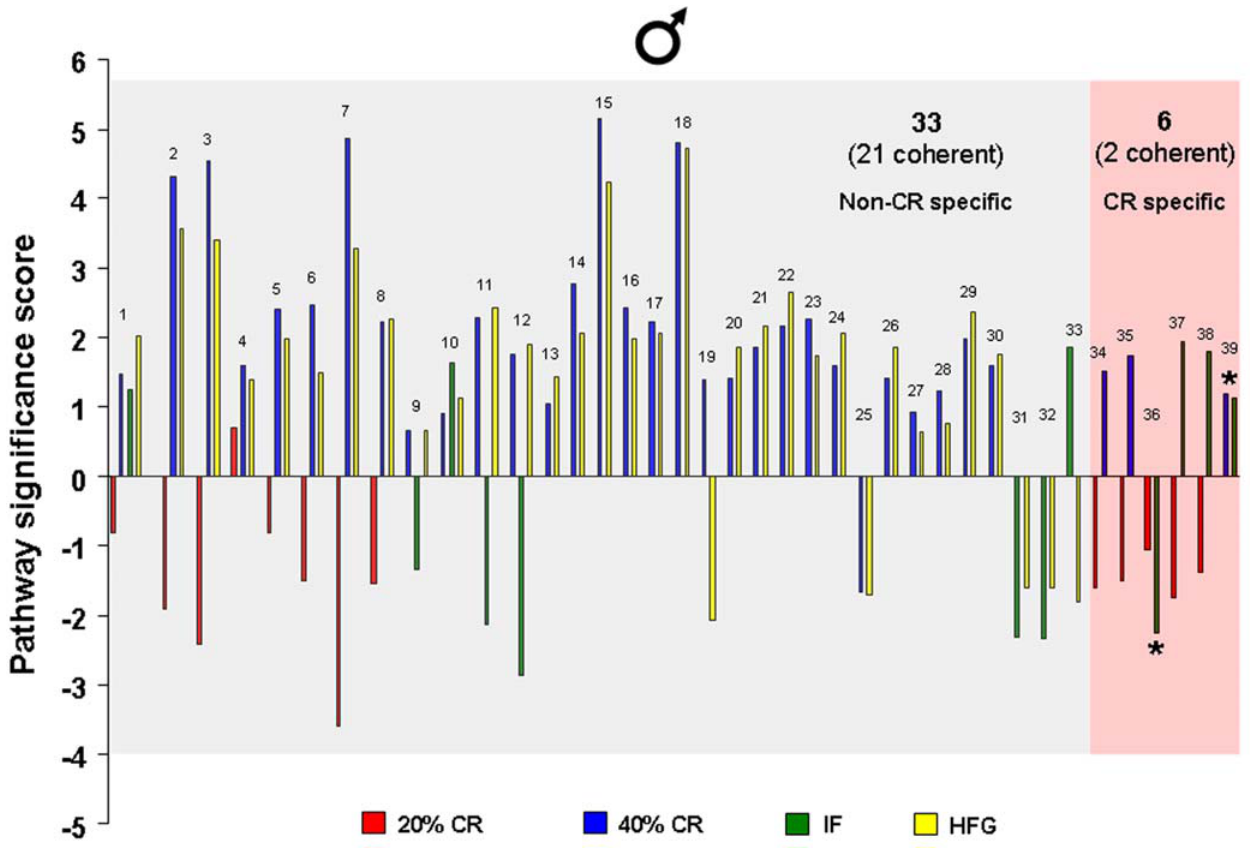
Figure 13. Males respond in an energy intake independent manner to dietary restriction and excess. The common-diet, significantly altered pathways in male hippocampi are summarized. There were similar changes in gene pathways between the 40% CR and HFG dietary groups, which suggests that the male hippocampal gene response to dietary restriction and excess was not calorie specific. Names of the significantly altered pathways can be found in Table